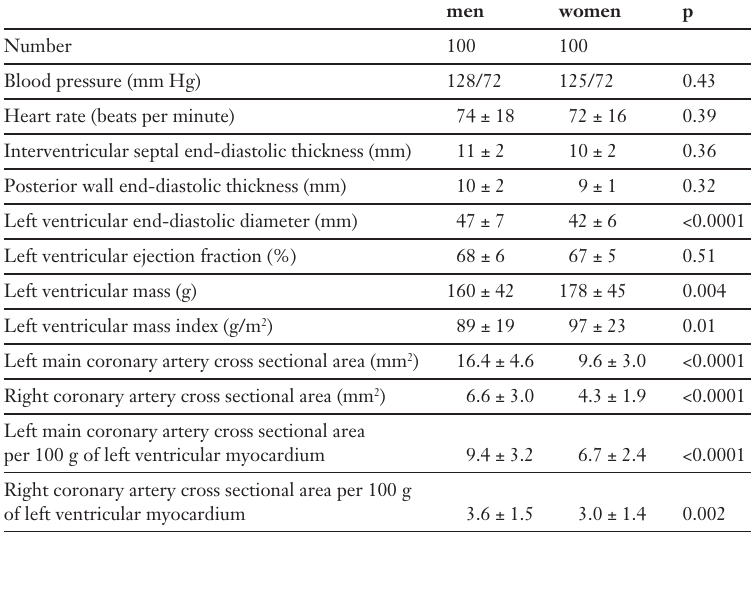
Gender differences of right coronary artery cross-sec- tional area in rela- tion to left ventric- ular mass. Thick solid curve: power equation fitting for measured RCA sizes (y = 0.07 x 0.84 , r = 0.41, p <0.0001, SEE [standard error of estimate] = 2.5 mm 2 ).